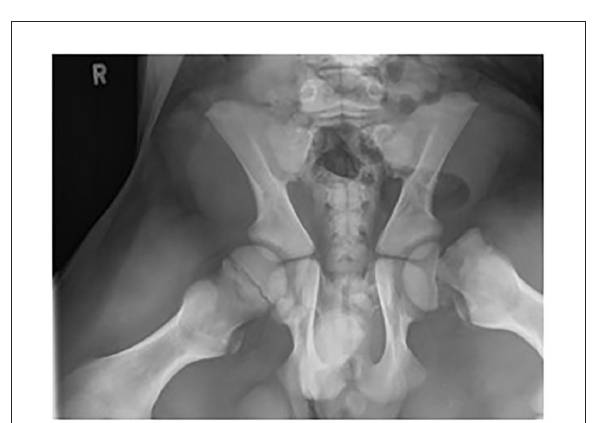
FIGURE3 Ventral-dorsal projection of the pelvis demonstrating a type 1 Salter-Harris (capital physeal) fracture in the left proximal femoral physis (case